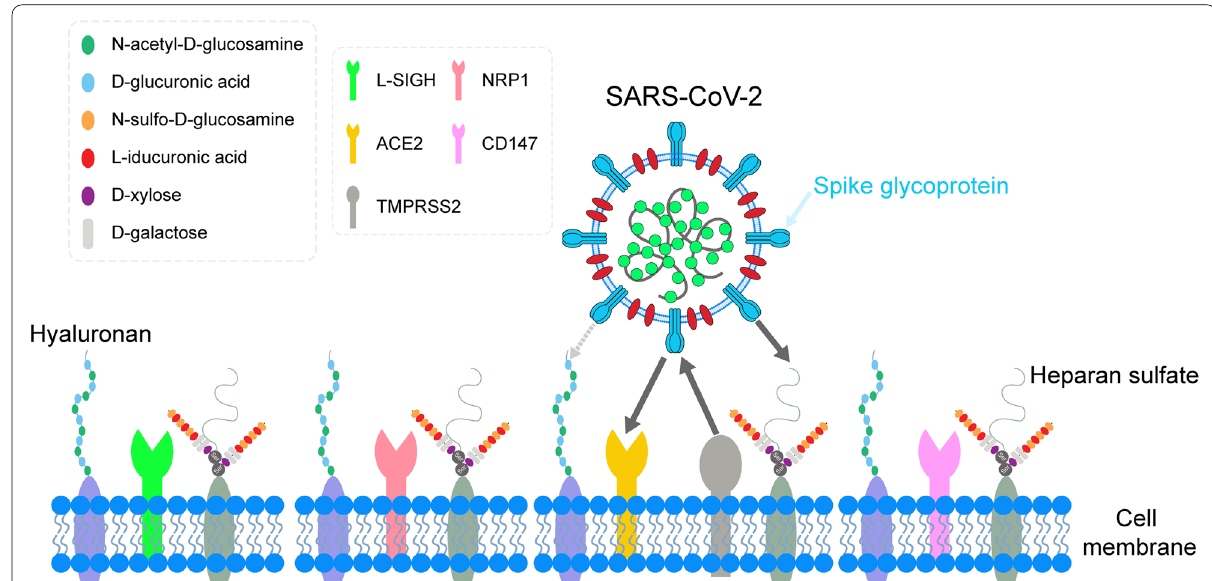
Fig. 1 The model of SARS-CoV-2 entry into host cells. SARS-CoV-2 could initiate its attachment to the host cell membrane using the glycans (such as hyaluronan and heparan sulfate). Then, the interaction between spike glycoprotein and diverse receptors gives the susceptibility SARS-CoV-2 needs to invade host cells. Notably, hyaluronan is universal in the extracellular matrix of different cells, which may explain the infection of SARS-CoV-2 into cells only with a high viral